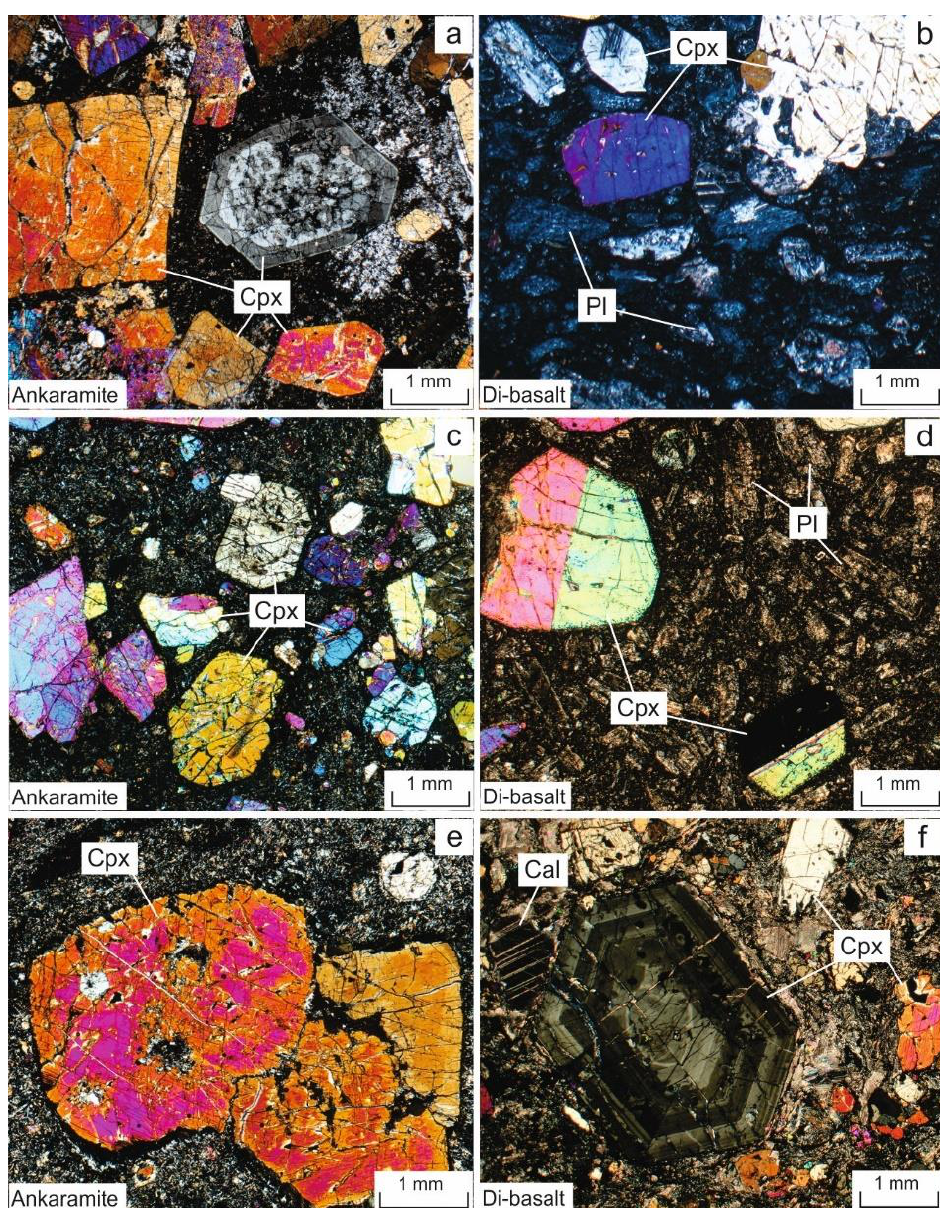
Figure 2. Microphotographs of thin sections of the Ust’ -Sema Formation volcanic rocks, Gorny Altai, (cross-polarized light): ( a , b ) Biyka volcanic edifice; ( c , d ) Ust’ -Sema volcanic edifice; ( e ) Anos-Emurla volcanic edifice; ( f ) Kamlak unit. Cal — calcite; Cpx — clinopyroxene; Pl — plagioclase. volcanic edifice; ( f ) Kamlak unit. Cal—calcite; Cpx—clinopyroxene;